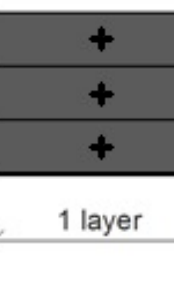
Figure 13. Beam specimen section design. Table 5. Four-point bending test results.